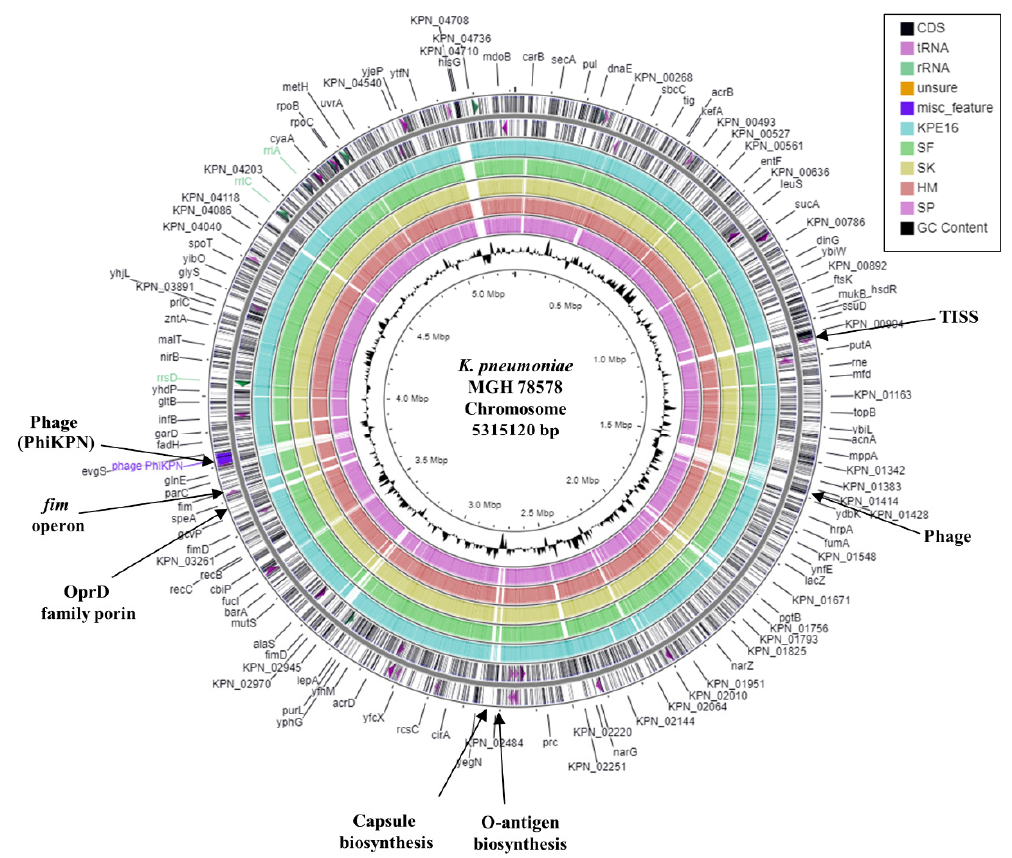
Figure 1. Comparison of the K. pneumoniae MGH 78578 chromosome with the draft genomes of K. pneumoniae strains KPE16, SF, SK, HM, and SP. The figure shows the comparison of the K. pneumoniae MGH 78578 chromosome with the genomes of K. pneumoniae strains KPE16, SF, SK, HM, and SP using GCview [32]. The outer two rings display the genes (CDS) and features of the K. pneumoniae MGH 78578 chromosome (CP000647.1) on both strands, with selected features labelled [30]. The blue, green, gold, red, and pink rings illustrate the BLAST results when the genome sequences of KPE16, SF, SK, HM, and SP, respectively, are compared to the MGH 78578 chromosome, with shaded regions indicating homology. The inner ring displays the GC content (black) for the K. pneumoniae MGH 78578 chromosome.